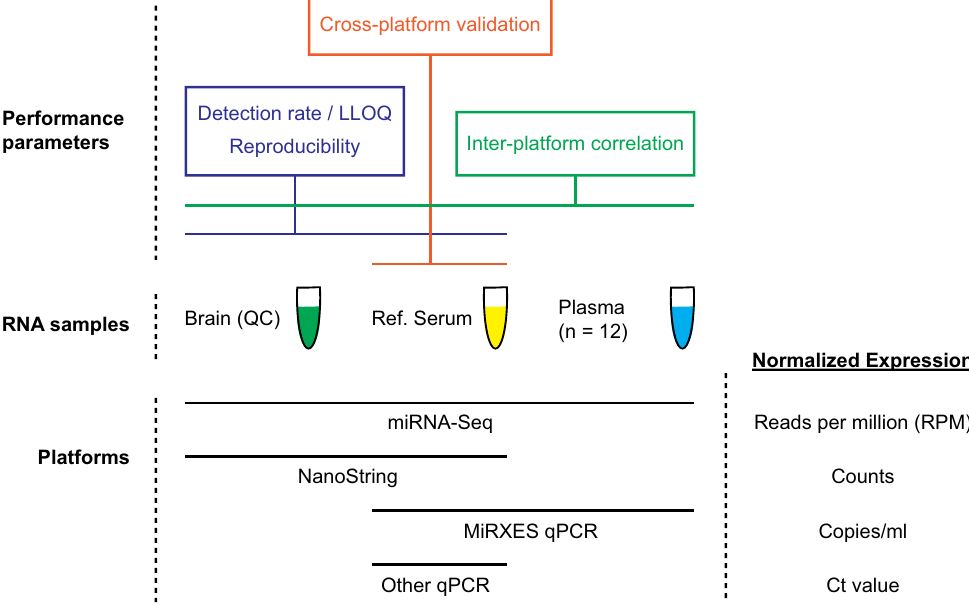
Figure 1. Overview of microRNA quantitation platforms, RNA samples, and different aspects of platform performance that were assessed in this study. Other qPCR platforms are Qiagen, ABI and Exiqon.